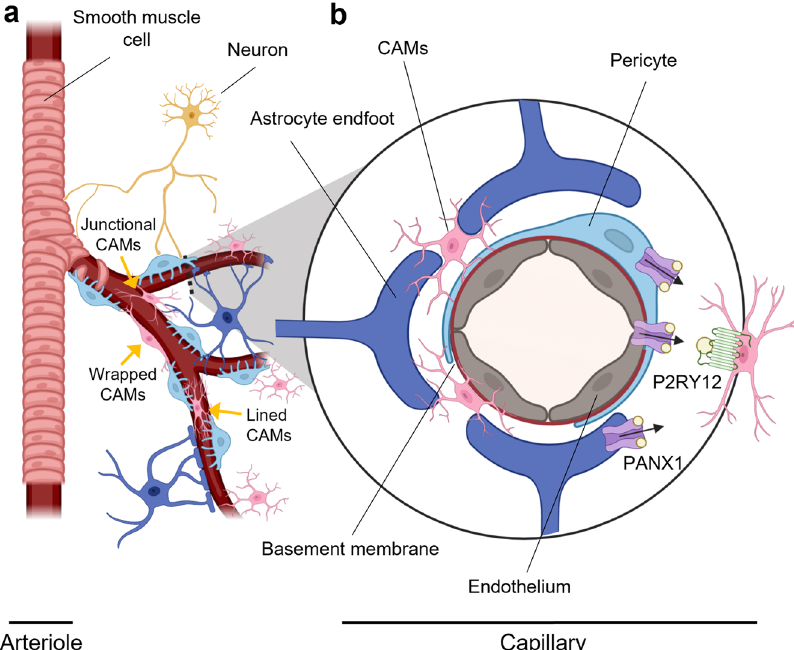
Fig. 1 Microglia positioning in the neurovascular unit. a Schematic of the neurovascular unit, which is comprised of neurons, vascular cells (endothelial cells, pericytes, smooth muscle cells) and glia (astrocytes, microglia). Endothelial cells (gray) are separated from pericytes (light blue) by the basement membrane (red). Astrocytes make contacts with both pericytes and endothelial cells at the capillary wall with their astrocytic endfeet (dark blue). Neurons (gold) innervate contractile cells of the vessel walls — smooth muscle cells in arterioles, and pericytes in brain capillaries. Capillary-associated microglia (CAMs; pink) make close contacts with brain capillary wall especially in areas not covered by astrocyte endfeet. Bisht et al. 9 identi fi ed three types of CAMs with lined, wrapped or junctional morphologies in relation to brain capillaries. b Inset shows brain capillary with P2RY12 (green)-positive microglia that are activated by purines (yellow circles) released from PANX1 channels (purple) from the brain capillary wall likely expressed in endothelial cells, and/or pericytes or astrocyte endfeet. Bisht et al. 9 have identi fi ed a signaling mechanism that attracts and maintains CAMs at the capillary